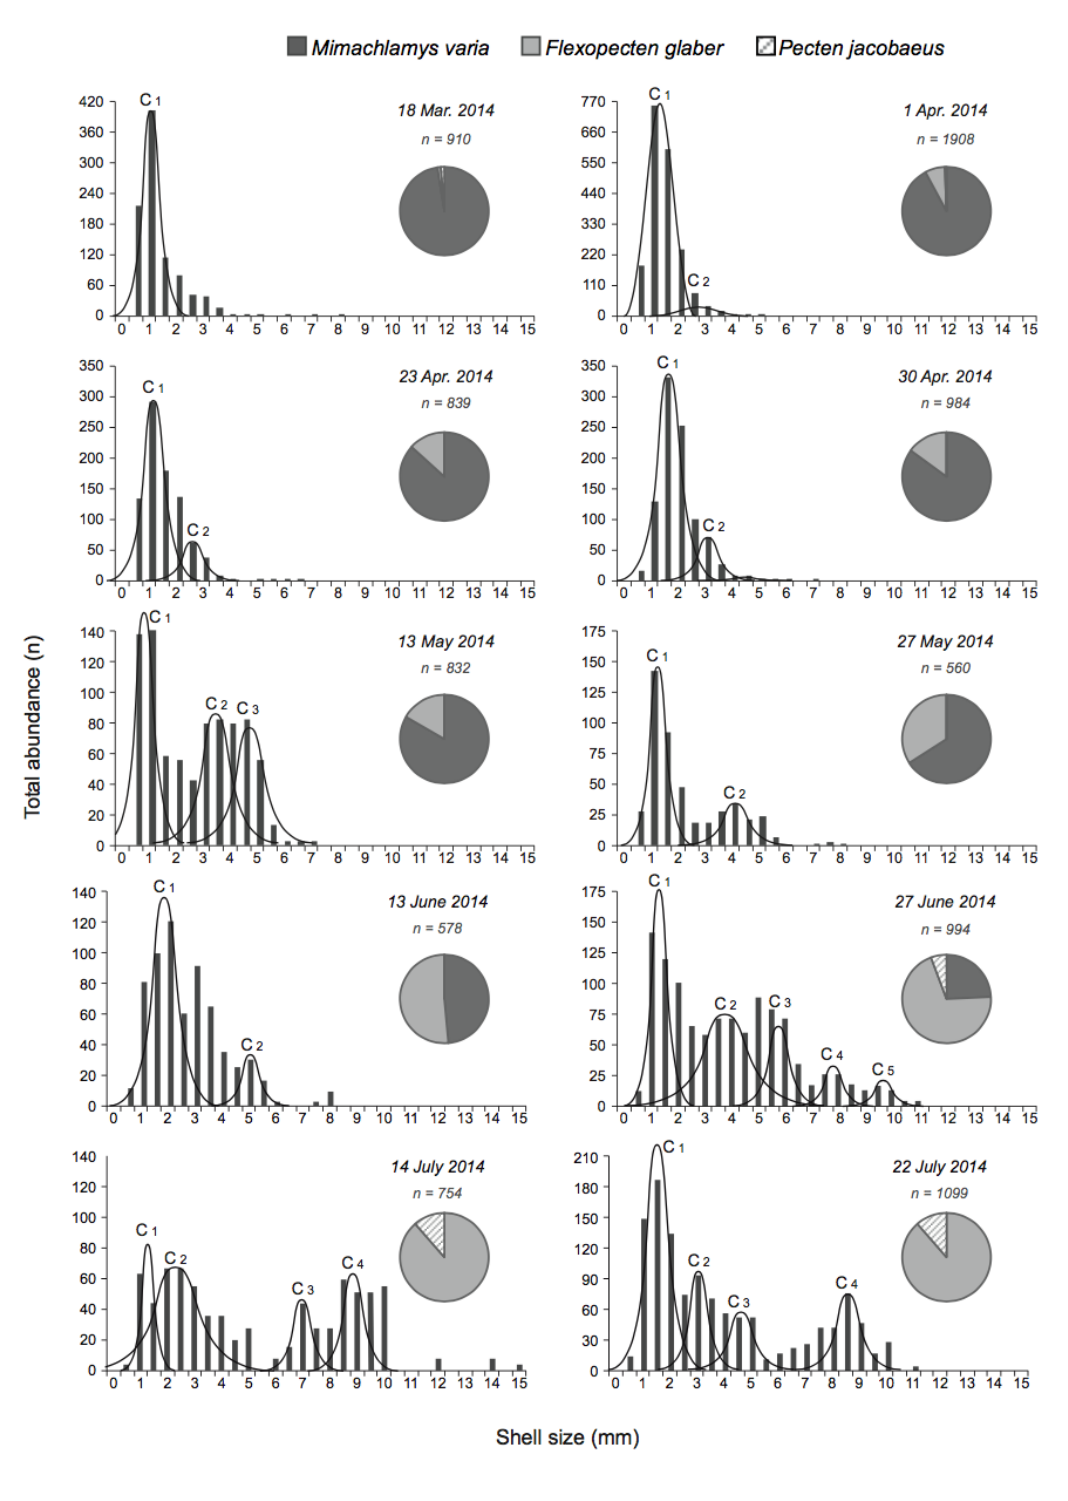
Figure 5. ( a ). Modal analysis of size frequency distributions (from 18 March 2014 to 22 July 2014) of Pectinidae recruited on artificial collectors in the Gulf of Taranto. In ( b , c ), modal analysis of size frequency distributions, the pie charts represent the frequency of occurrence of each Pectinidae at each sampling date.